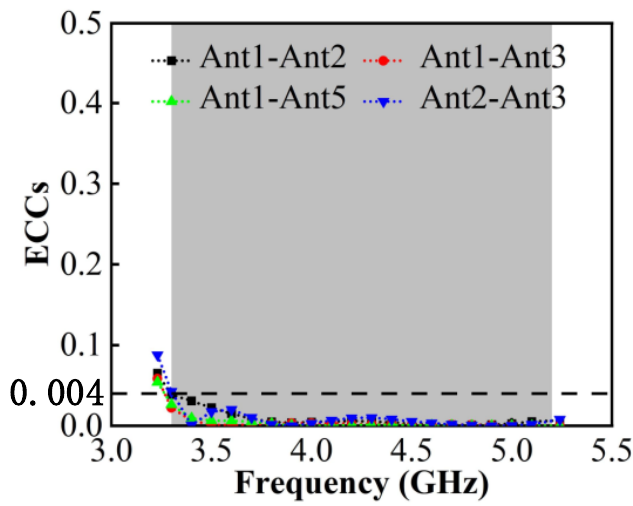
Figure 15. Calculated ECCs.